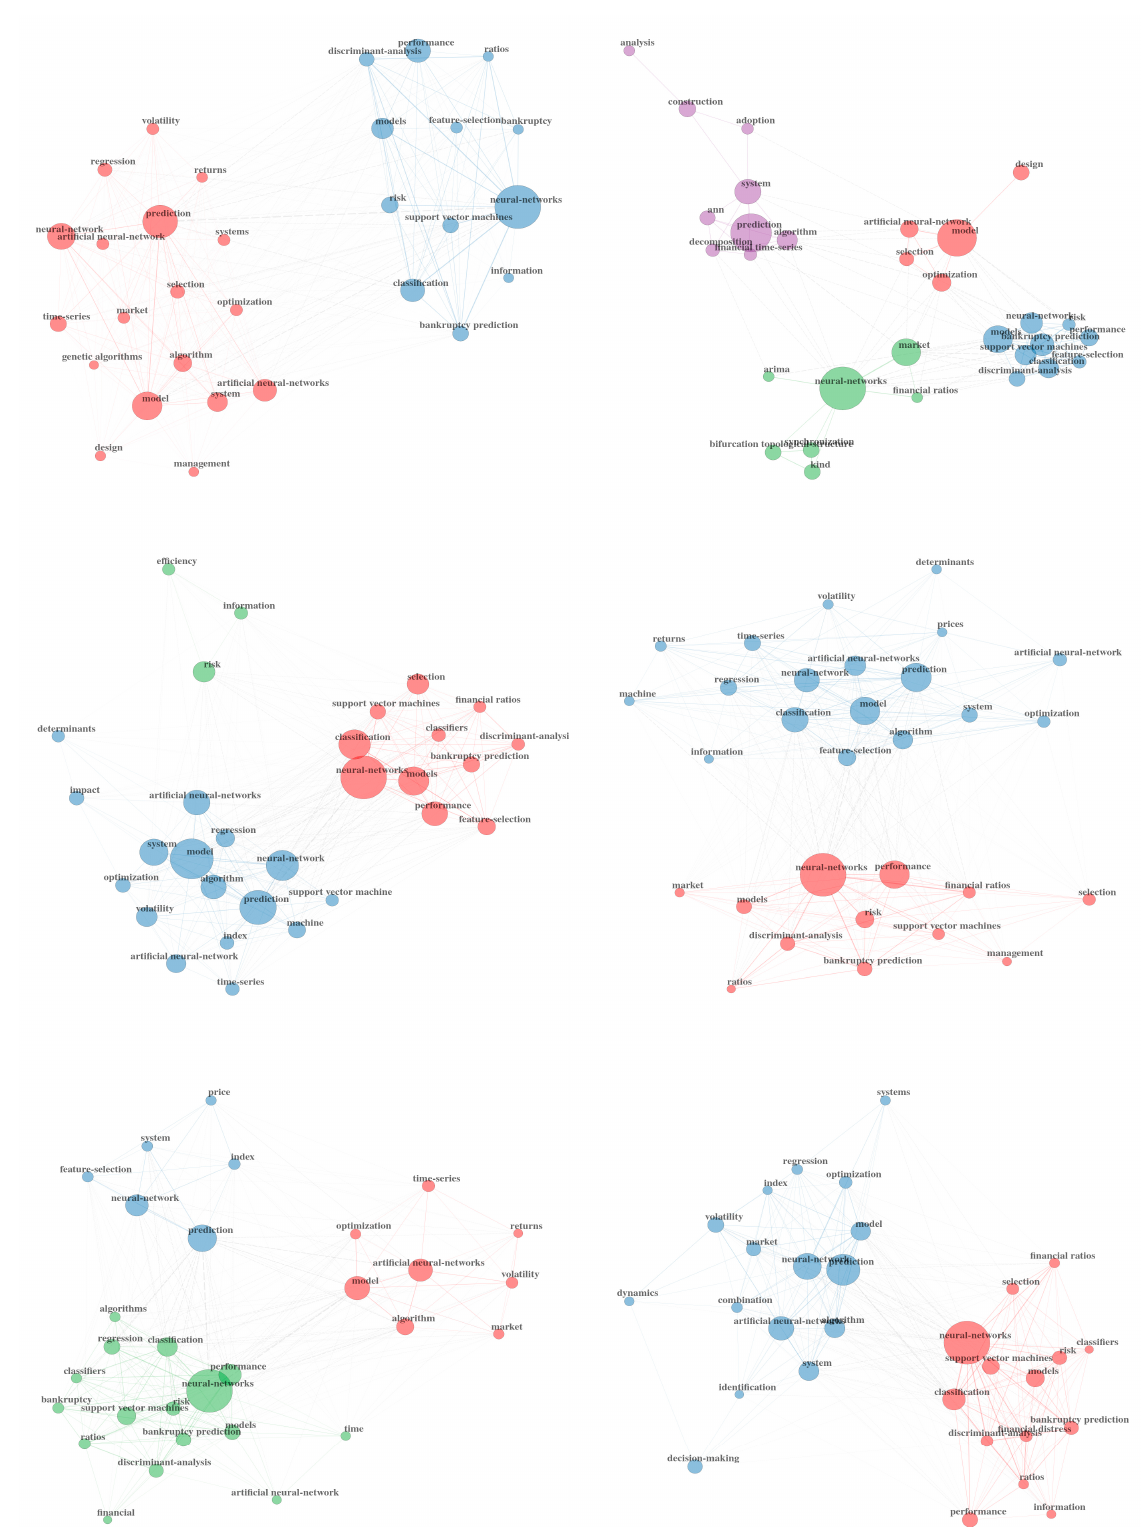
Figure 3. Network of authors’ keywords, overall period, and per year.